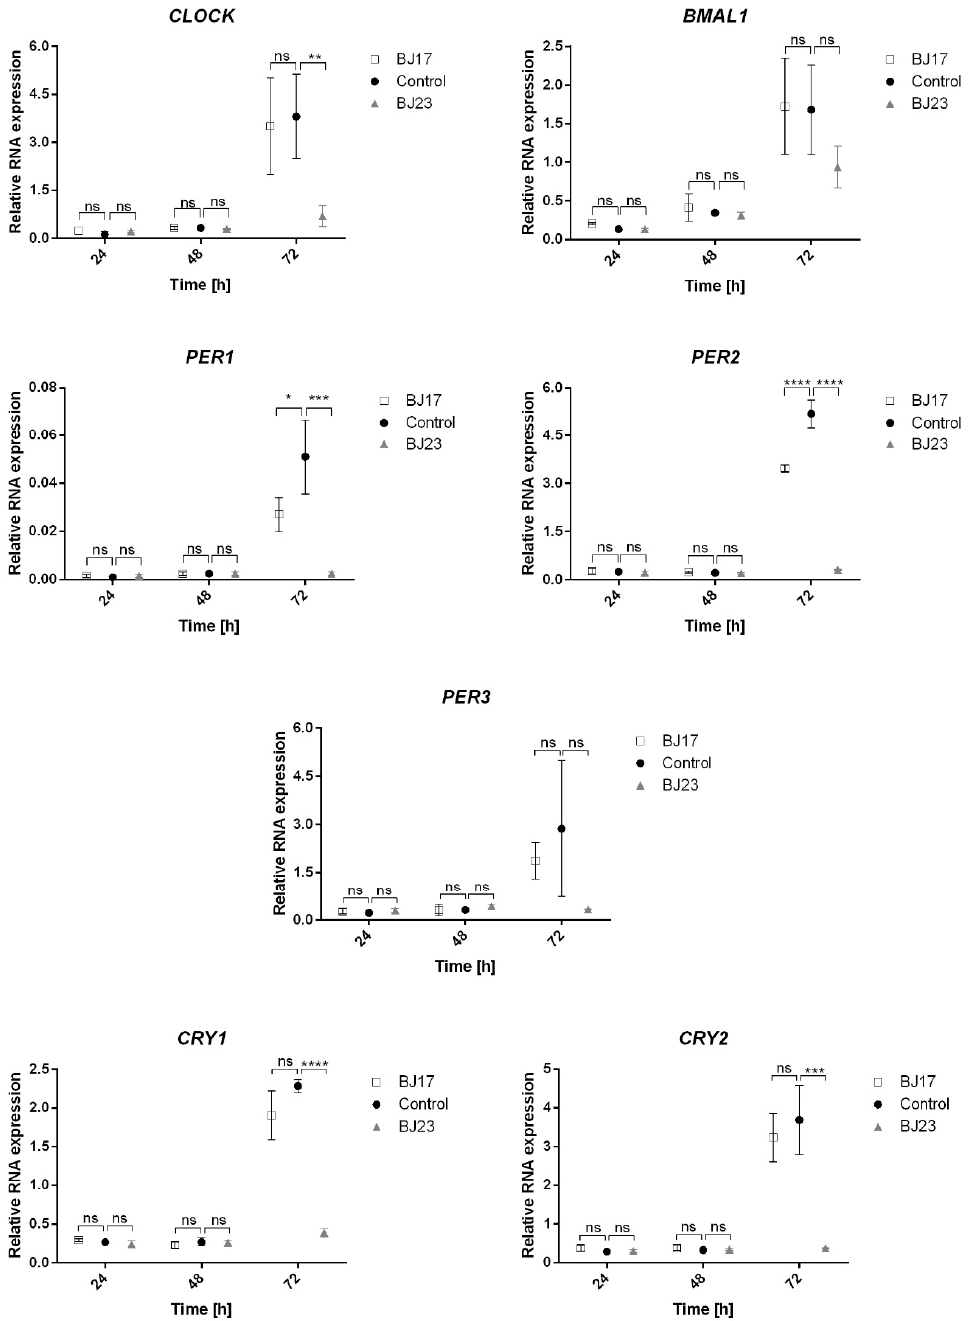
Figure 3. Relative expression of the core circadian genes as a function of time (24–72 h). BJ17 (white squares), BJ23 (grey triangles): co-cultures of BJ strain with the HepG2 cells. Control (black circles): HepG2 cells without bacteria. Statistically significant results were presented; not significant (ns) for p > 0.05, * for p ≤ 0.05, ** for p ≤ 0.01, *** for p ≤ 0.001 and **** for p ≤ 0.0001. Data are represented as mean ± SD of two separate experiments.